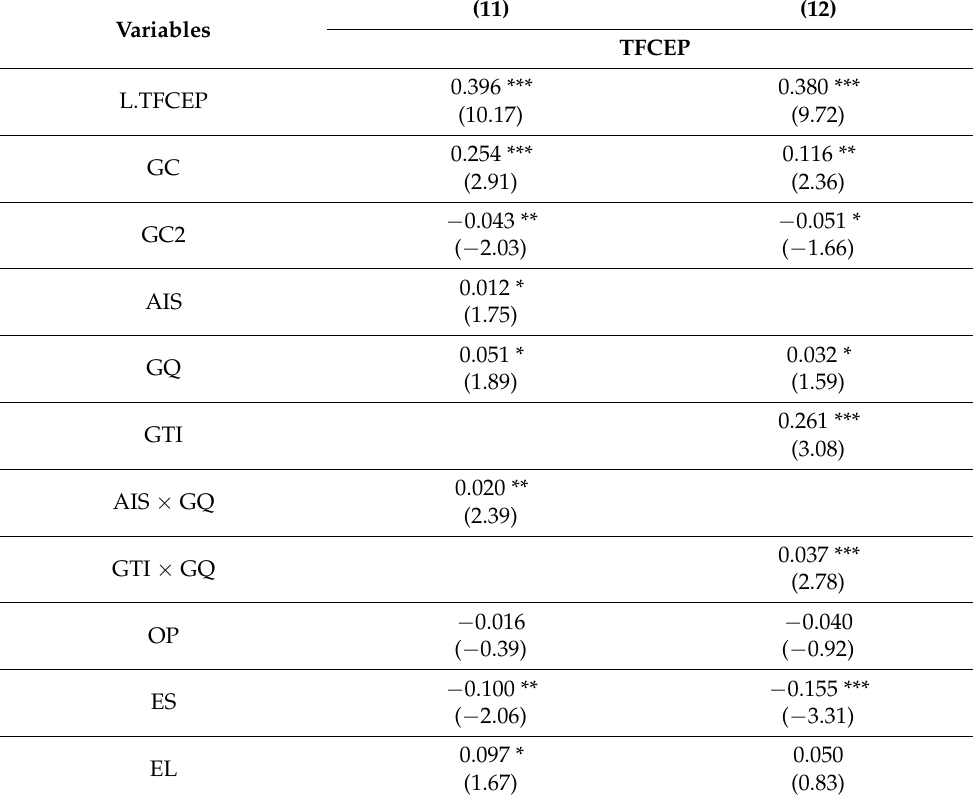
Table 5. Regression results of moderated mediation